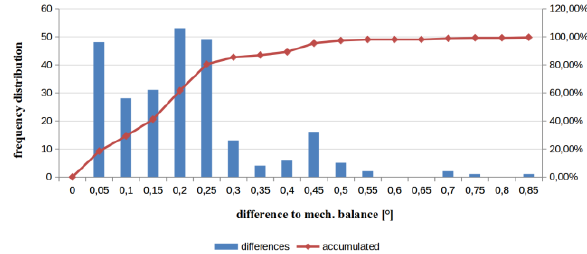
Figure 12. Histogram of the differences between the optical point-to-point and the mechanical measurement method